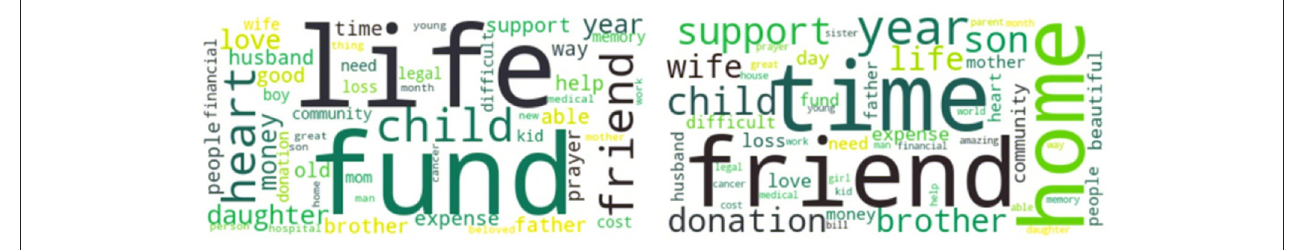
FIGURE 4 | Topics under the Other category that had significant effect on success during the COVID-19 pandemic. We generate two topics with the best coherence value: